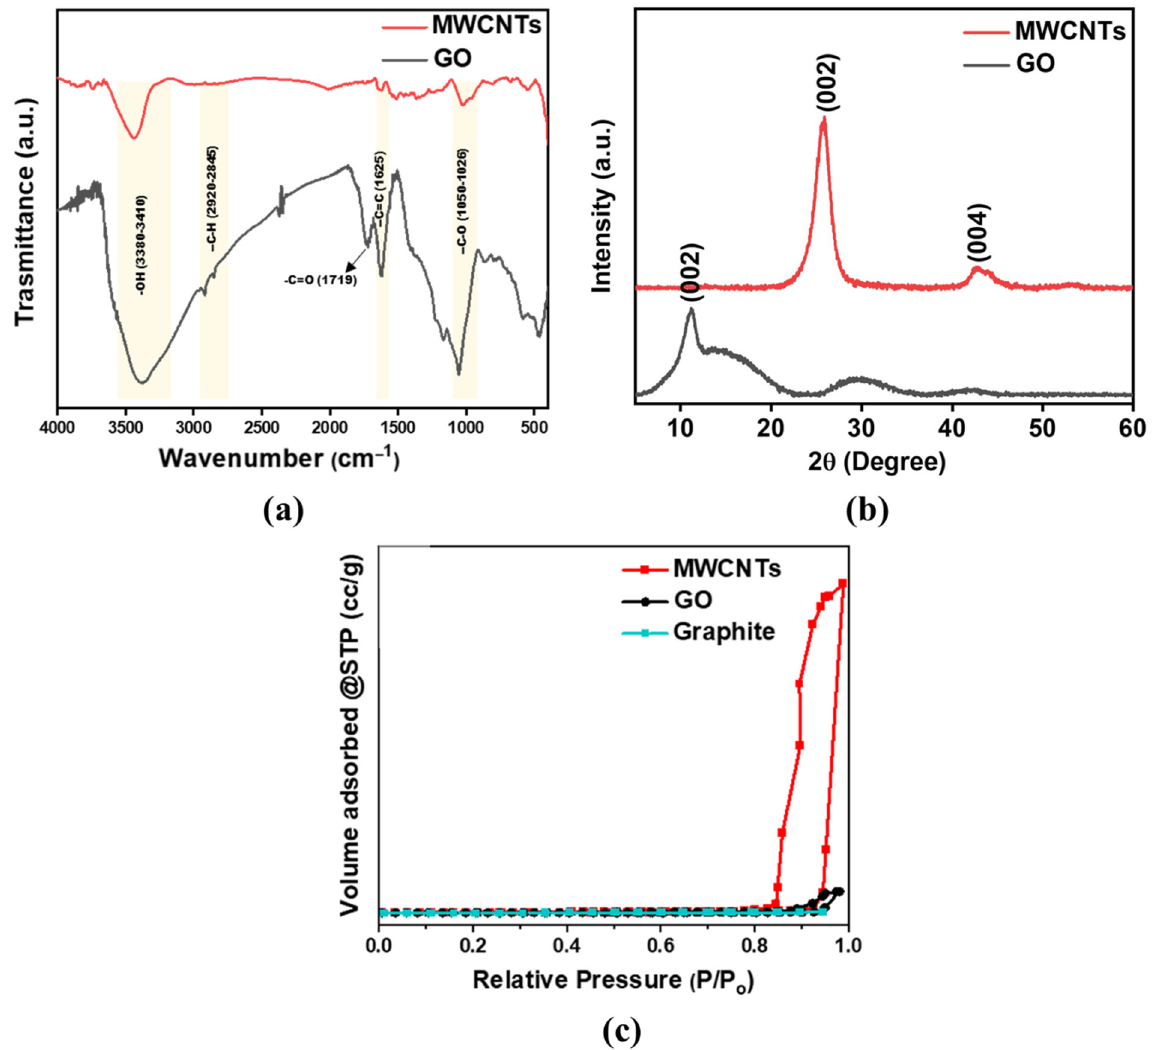
Figure 2. ( a ) FTIR spectra of MWCNTs and GO, ( b ) XRD spectra of MWCNTs and GO, and ( c ) N 2 adsorption-desorption isotherm of MWCNTs, GO, and graphite.